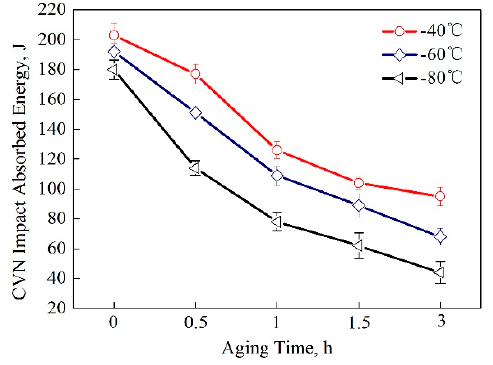
Figure 7. The Charpy V-notch (CVN) impact absorbed energies of the tested steel samples.